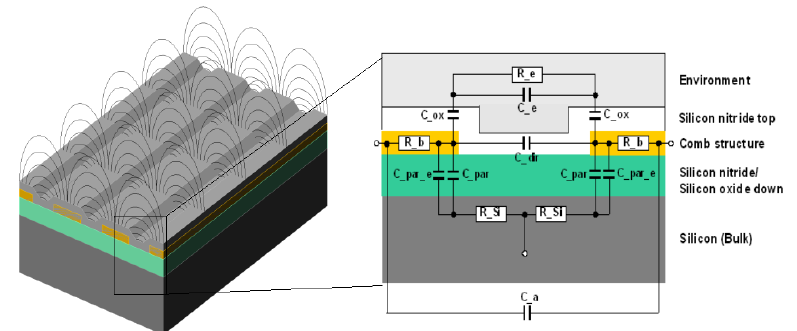
Fig.7: Tetrapolar electrode made from a CD-R. The dimension of the inner electrodes is 100 (cid:80) m. For electrical characterization of the electrodes, measurements in bulk electrolytes were done with the leads passivated using Tesa tape (Bayersdorf AG, Hamburg,